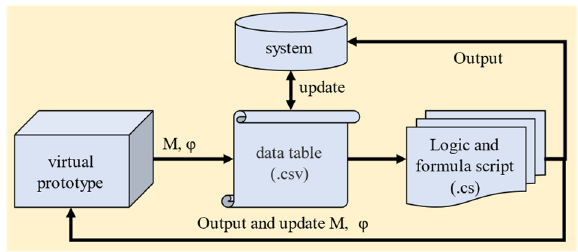
Figure 16. Data processing of the knowledge